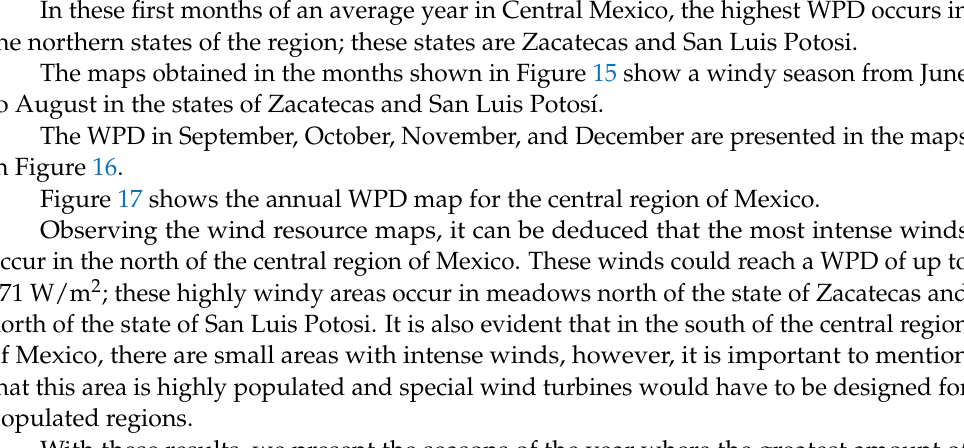
Figure 17. Annual WPD in Central Mexico.